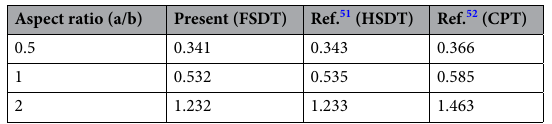
Table 3. Comparison study of non-dimensional natural frequency of a MEE plate.